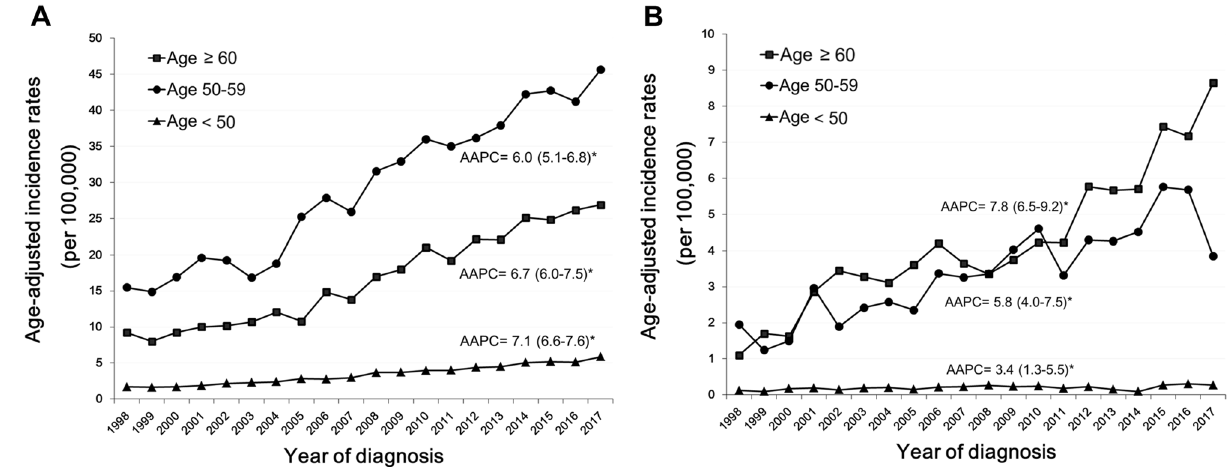
Figure 2. Incidence rates of endometrial cancer in Taiwan between 1998 and 2017. Age-adjusted incidences of ( A ) endometrioid and ( B ) nonendometrioid carcinoma in the 3 age groups. Trends are summarized by the annual percentage change estimate (95% CI). (*) Significantly different than zero at P <